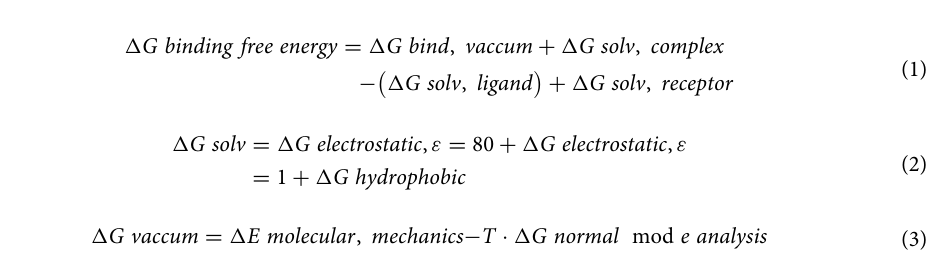
Figure 1. Pan-core plot of 34 Mycobacteroides abscessus genomes. With the inclusion of each new genome, the size of the pangenome increased while that of the core genome decreased. The pangenome curve (shown in brown) continues to show an upward trajectory. This suggests that the global gene pool of M. abscessus is likely to increase in the